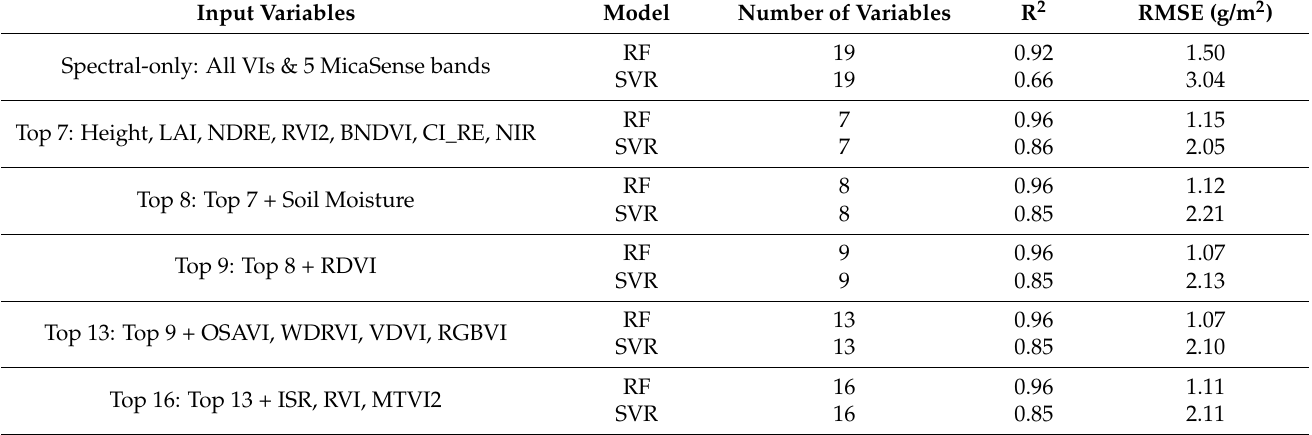
Table 9. Statistics for the calibration of the canopy nitrogen model with 12, 20, and 27 May MicaSense data and different combinations of variables ( n = 89) 1 .